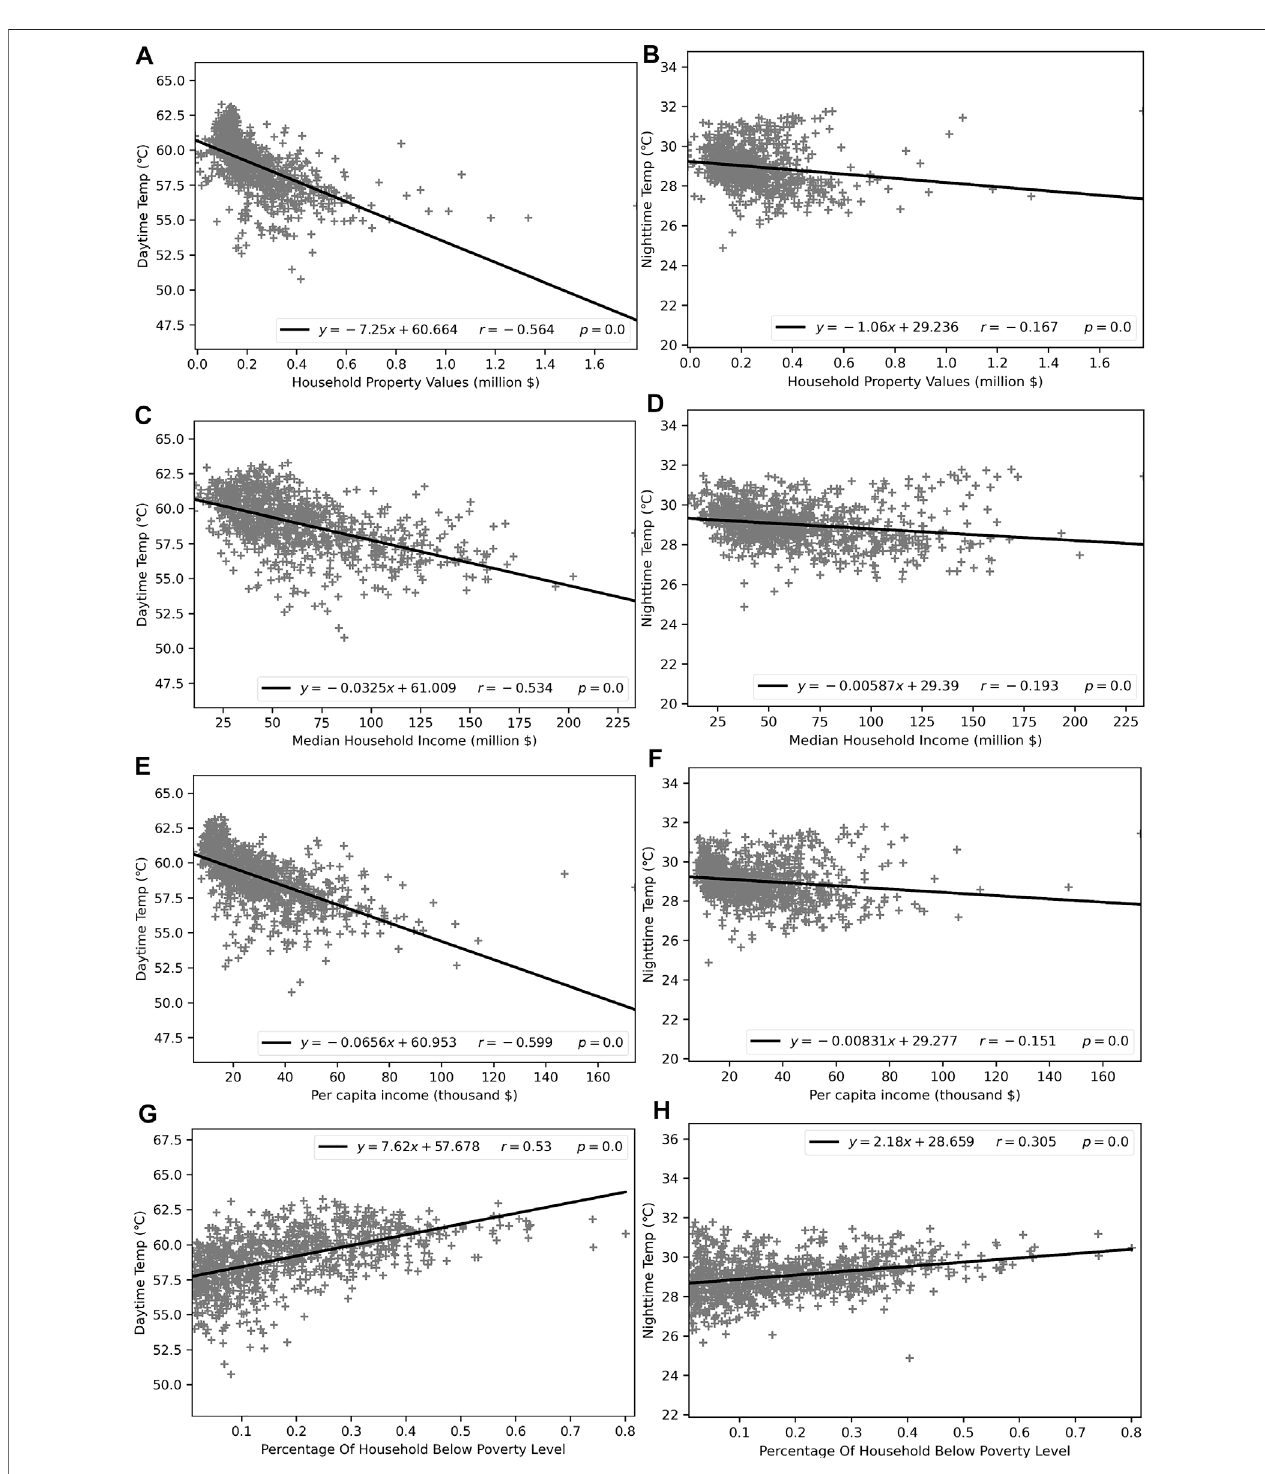
FIGURE 7 | Disproportionate impacts of UHI on socioeconomically disadvantaged communities in Phoenix ’ s urban core were identi fi ed by linear regression between (A) summer daytime LST and house property values, (B) summer nighttime LST and house property values, (C) summer daytime LST and median household income, (D) summer nighttime LST and median household income, (E) summer daytime LST and per capita income, (F) summer nighttime LST and per capita income, (G) summer daytime LST and percentage of households below the poverty line, and (H) summer nighttime LST and percentage of household below the poverty